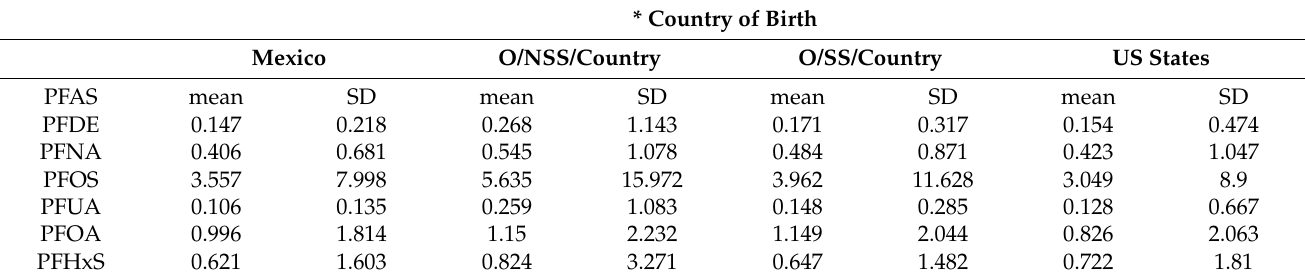
Table 3. PFAS mean (ng/mL) and standard deviation by the country of